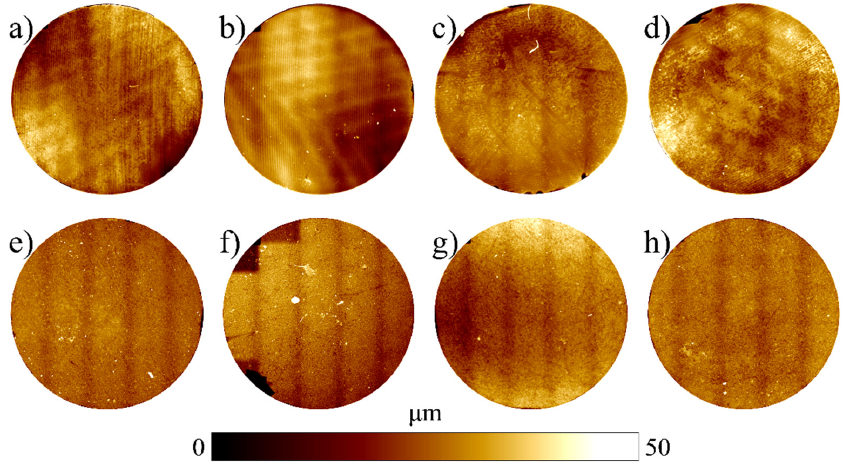
Figure 3. Low-magnification laser microscopy images of the surface of the samples. ( a ) dentine control, ( b ) dentine with bisphosphonate, ( c ) dentine with RANKL, ( d ) dentine with both phosphonate and RANKL, ( e ) octalcium phosphate, ( f ) octalcium phosphate with bisphosphonate, ( g ) octacalcium phosphate with RANKL and ( h ) octacalcium phosphate with both bisphosphonate and RANKL.